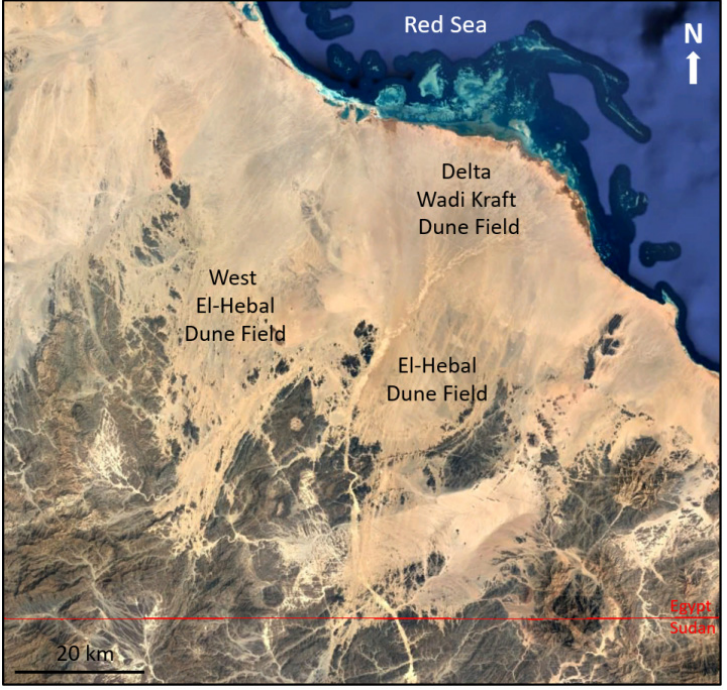
Figure 6. Location of the three dune fields of the SE Eastern Desert. Source: Google Earth image © 2019 CNES/Airbus.